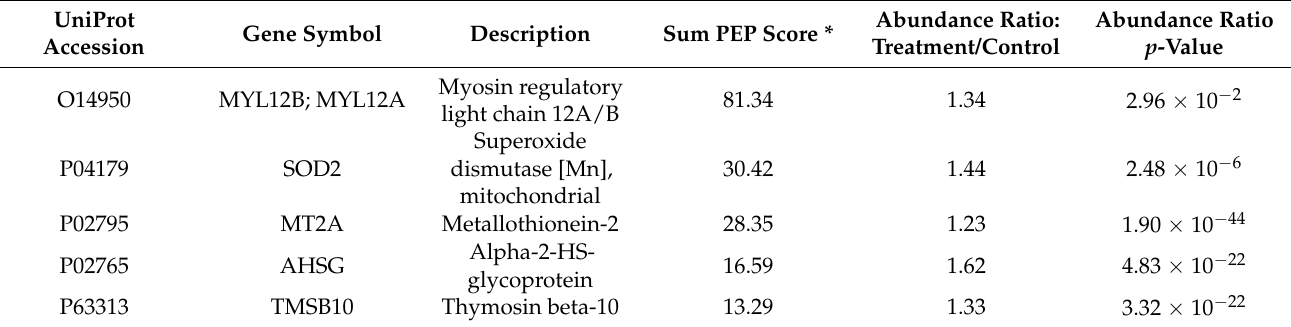
Table 4. Significantly overexpressed proteins in HGF cells after treatment with